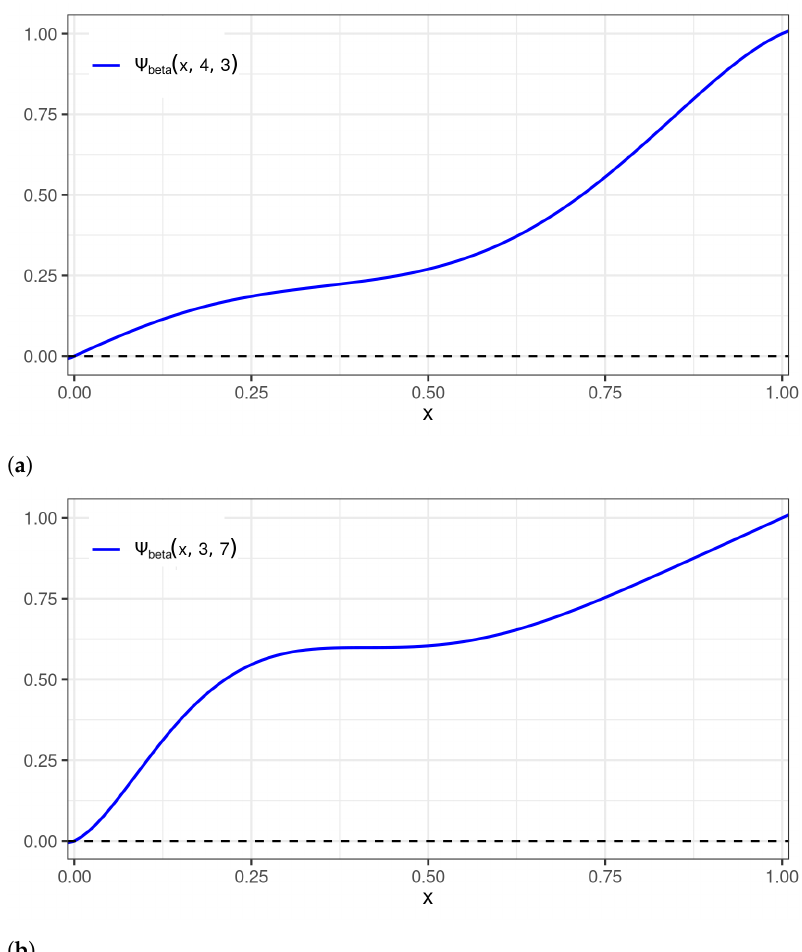
Figure 2. Plots of the beta wavelet perturbations: ( a ) ψ beta ( x ,4,3 ) ; and ( b ) ψ beta ( x ,3,7 )